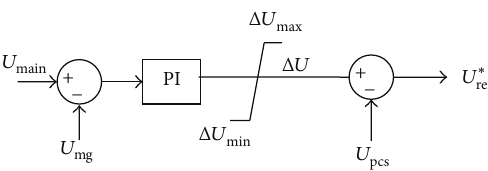
Figure 4: The voltage amplitude adjustment diagram.